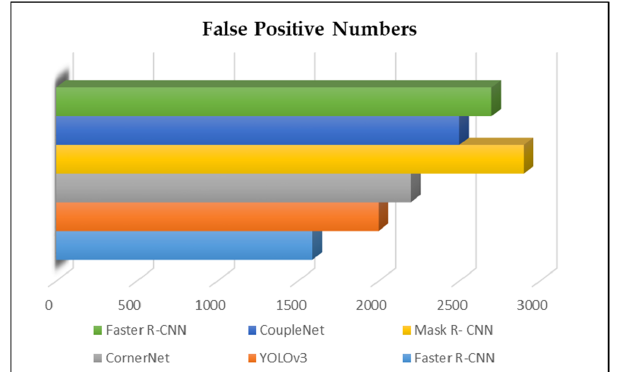
Figure 8. Visible results of false positive speech signal feature extraction experiments.